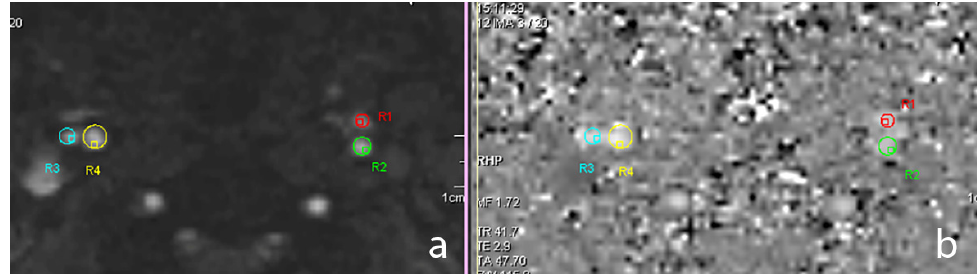
Figure 1. The 2D magnitude ( a ) and phase contrast ( b ) slice above the carotid bifurcation showing the cross-sectional areas in the regions of interest. R1: left external carotid artery. R2: left internal carotid artery. R3: right external carotid artery. R4: right internal carotid artery.